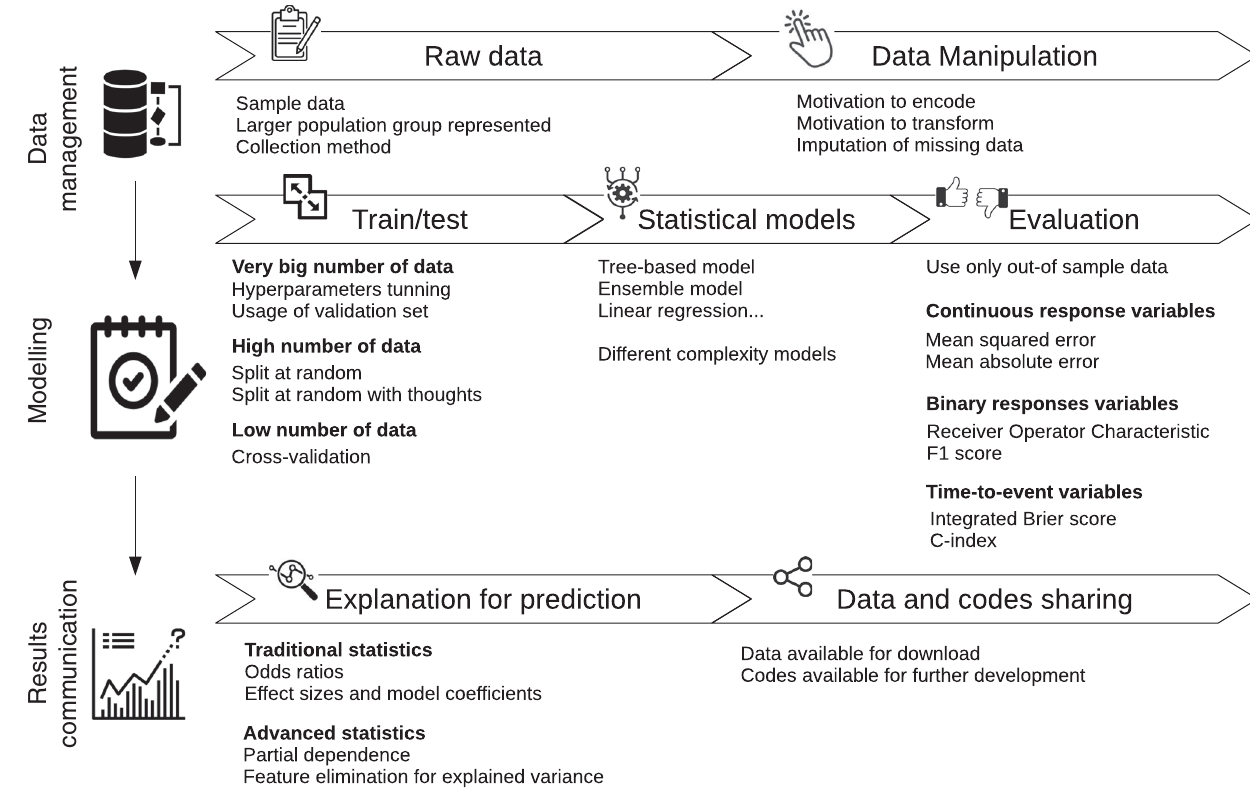
FIG. 1. A framework for building and evaluating statistical models in physics education